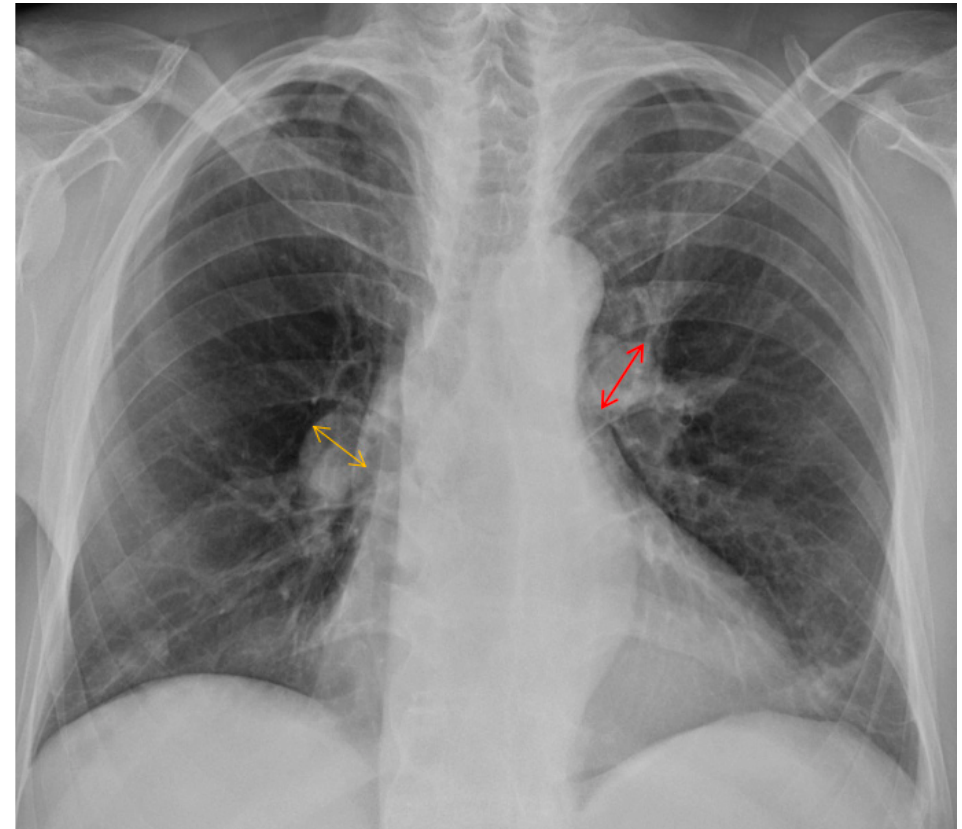
Figure 2. Chest radiograph showed engorged bilateral main pulmonary arteries and pruning of peripheral pulmonary vessels. The orange and reddish lines indicate the diameter of the right (21 mm) and left (24 mm) main pulmonary artery, respectively.